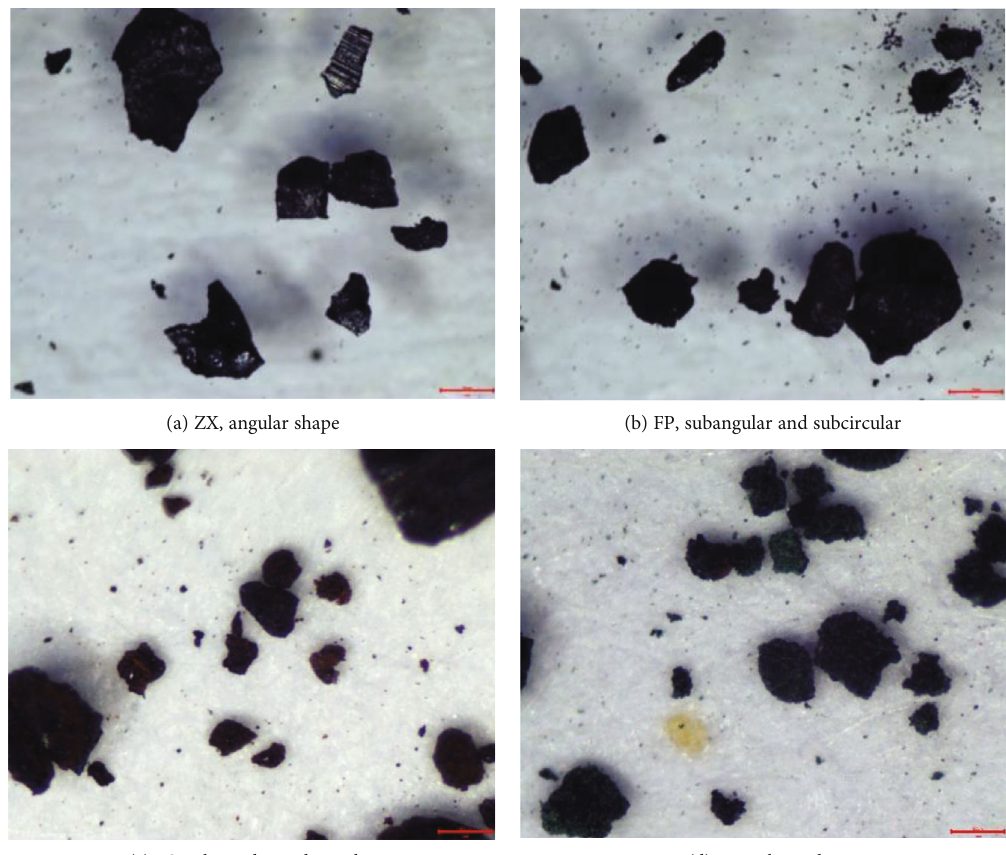
Figure 9: Photomicrograph of di ff erent types of coal fi nes.